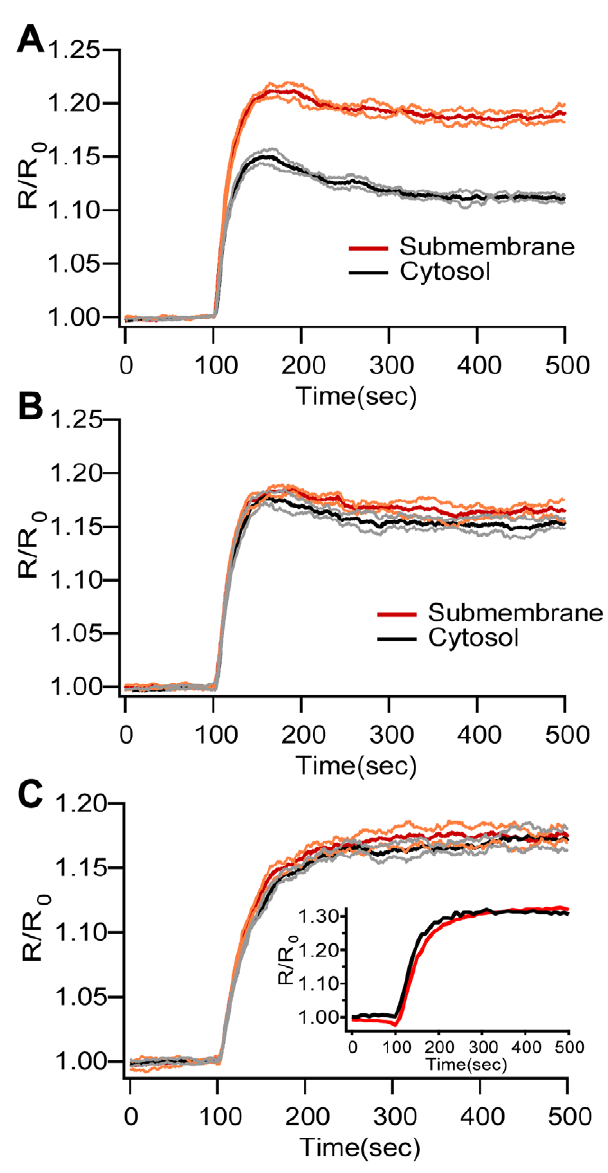
Figure 5. Mechanisms underlying cAMP microdomains. (A) Silencing of PDE4B does not eliminate the submembrane microdomain. (B) Silencing of PDE4D does eliminate the submembrane microdomain. (C) Blocking PDE4 phosphorylation by PKAc eliminates the submem- brane microdomain, and also eliminates the decay of the FRET signal from the peak. There is substantial overlap of cytosol and submem- brane standard deviation traces. These results suggest that PKA is the main effector of the microdomain through phosphorylation of PDE4s (inset shows representative experimental data). Mean and 6 SD traces in red and orange for submembrane and black and gray for cytosol, respectively (n=5).